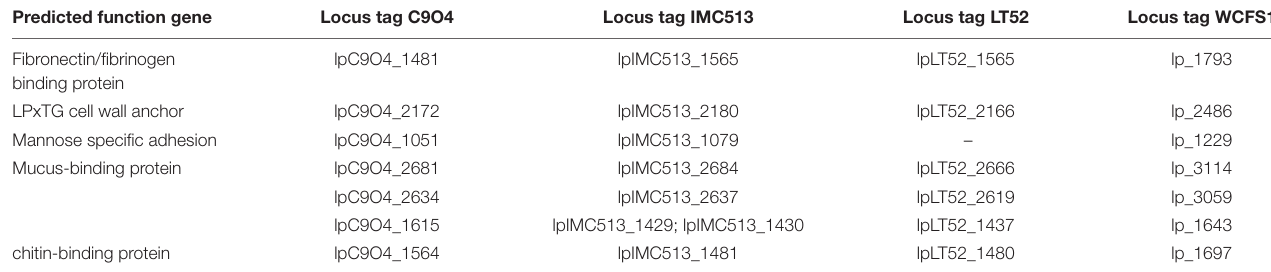
TABLE 7 | Prediction of genes related to host–microbe interactions. Predicted function gene Locus tag